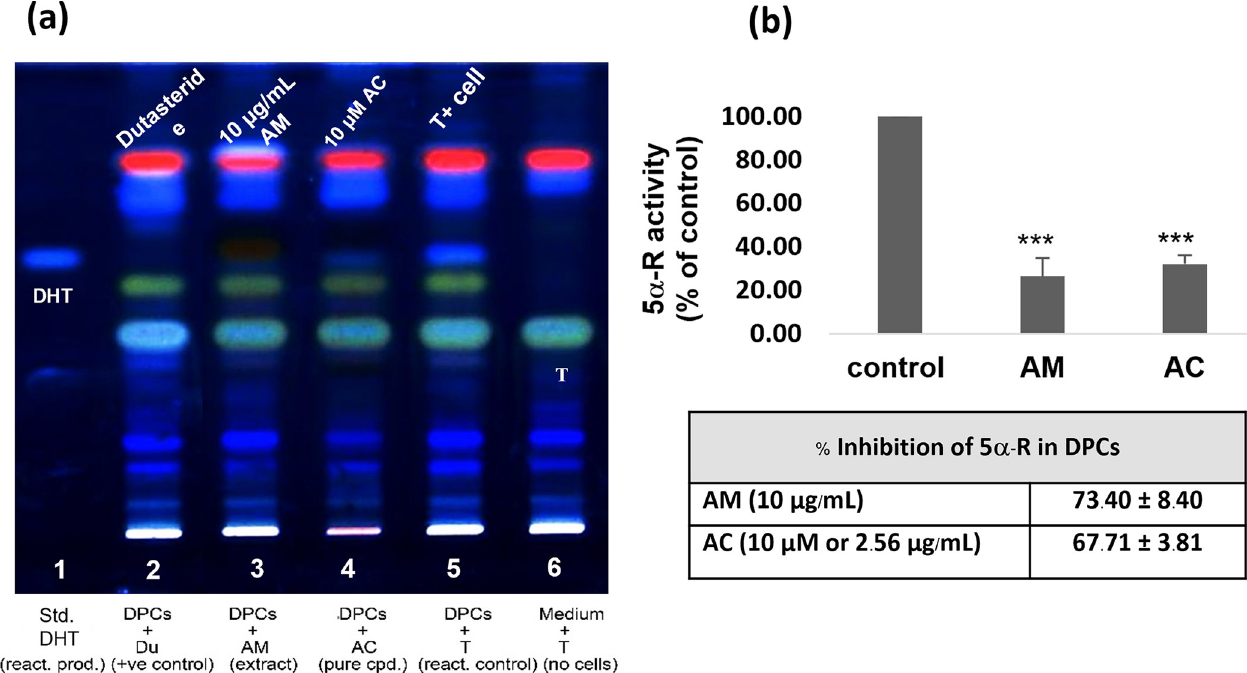
Fig 4. 5 α -R inhibitory effects of AM and AC by performing on TLC plate (a) A TLC plate showing the 5 α -R inhibitory activity of the AM extract (10 μ g/mL) (lane 3) and of AC (10 μ M) (lane 4), with dustasteride (1 μ M) being used as a positive control (lane 2). The internal control (cells without the inhibitor) is shown in lane 5, while the controls with standard DHT and cells with T are shown in lanes 1 and 6, respectively. (b) The bar graphs represent the percentage of DHT produced in the presence of the AM extract and the AC relatively to the internal control, with the obtained values presented in the Table. All data were obtained from experiments performed in triplicate, and are presented as mean ± SD (n = 3). *** p < 0.005 versus non-treated cells.